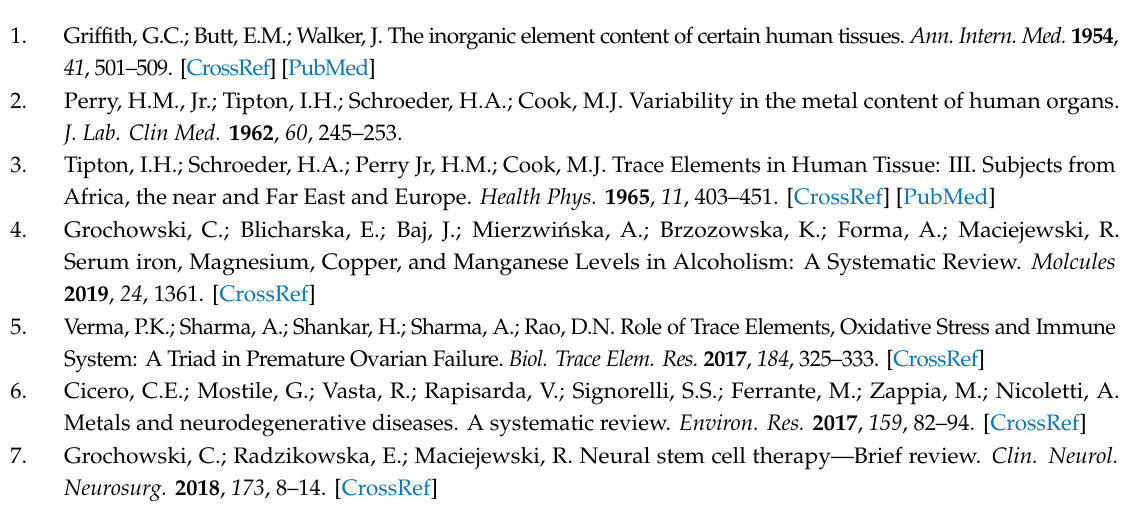
Table S1: Descriptive statistics. Statistics were calculated for each element by tested areas and groups (for data before logarithmic transformation). Table S2: Results of certified reference materials